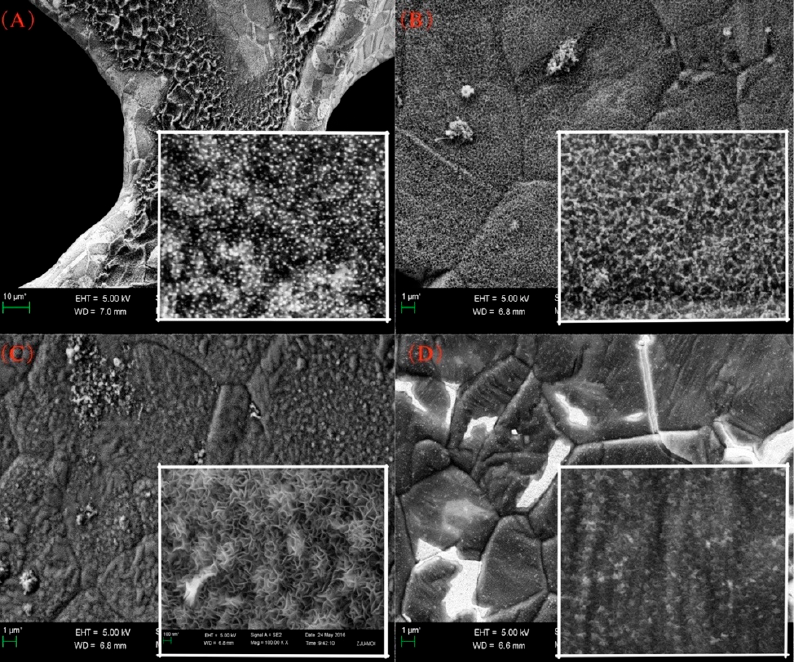
Figure 3. SEM images of VG sheets generated by PECVD at temperature of ( A ) 600 °C ; ( B ) 700 °C ; ( C ) 800 °C ; and ( D ) 900 °C . Power = 500 W, H 2 = 5 sccm, Ar = 20 sccm.